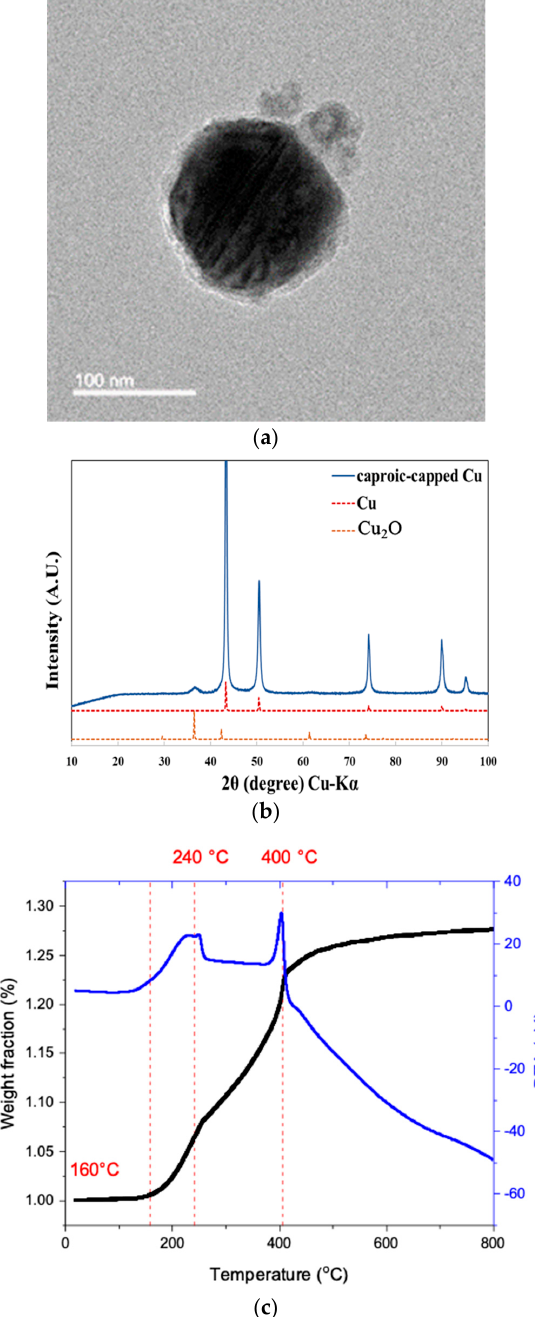
Figure 1. ( a ) Transmission electron microscope (TEM), ( b ) X-ray diffraction (XRD) and ( c ) TG-DTA curve of the synthesized copper nanoparticles. curve of the synthesized copper